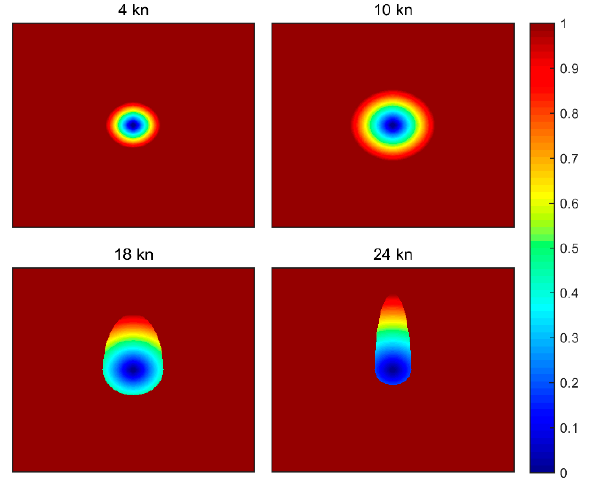
Figure 11. Ship domain and collision risk based on ship speed.